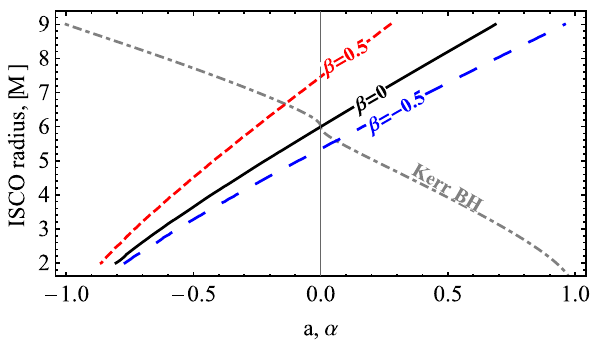
Fig. 14 The similar plot as Fig. 13, but for magnetic coupling and MOG parameters In Fig. 14, we present relations of the magnetic coupling and the MOG parameters giving the same ISCO radius. From Fig. 12 one can see that positive (negative) values of β param- eter can mimic negative (positive) values of the MOG param- eter, α , for the same radius of ISCO. One can see from Fig. 14 that the parameter β at ( β ∈ ( − 1 , 1 ) ) can mimic the MOG parameter in the range α ∈ ( − 0 . 17 , 0 . 28 )